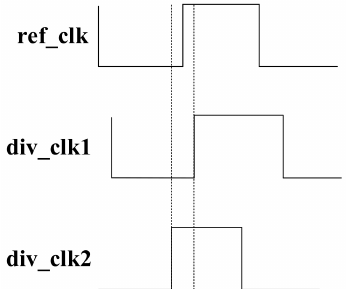
Figure 4. Operating principle of the FC module.